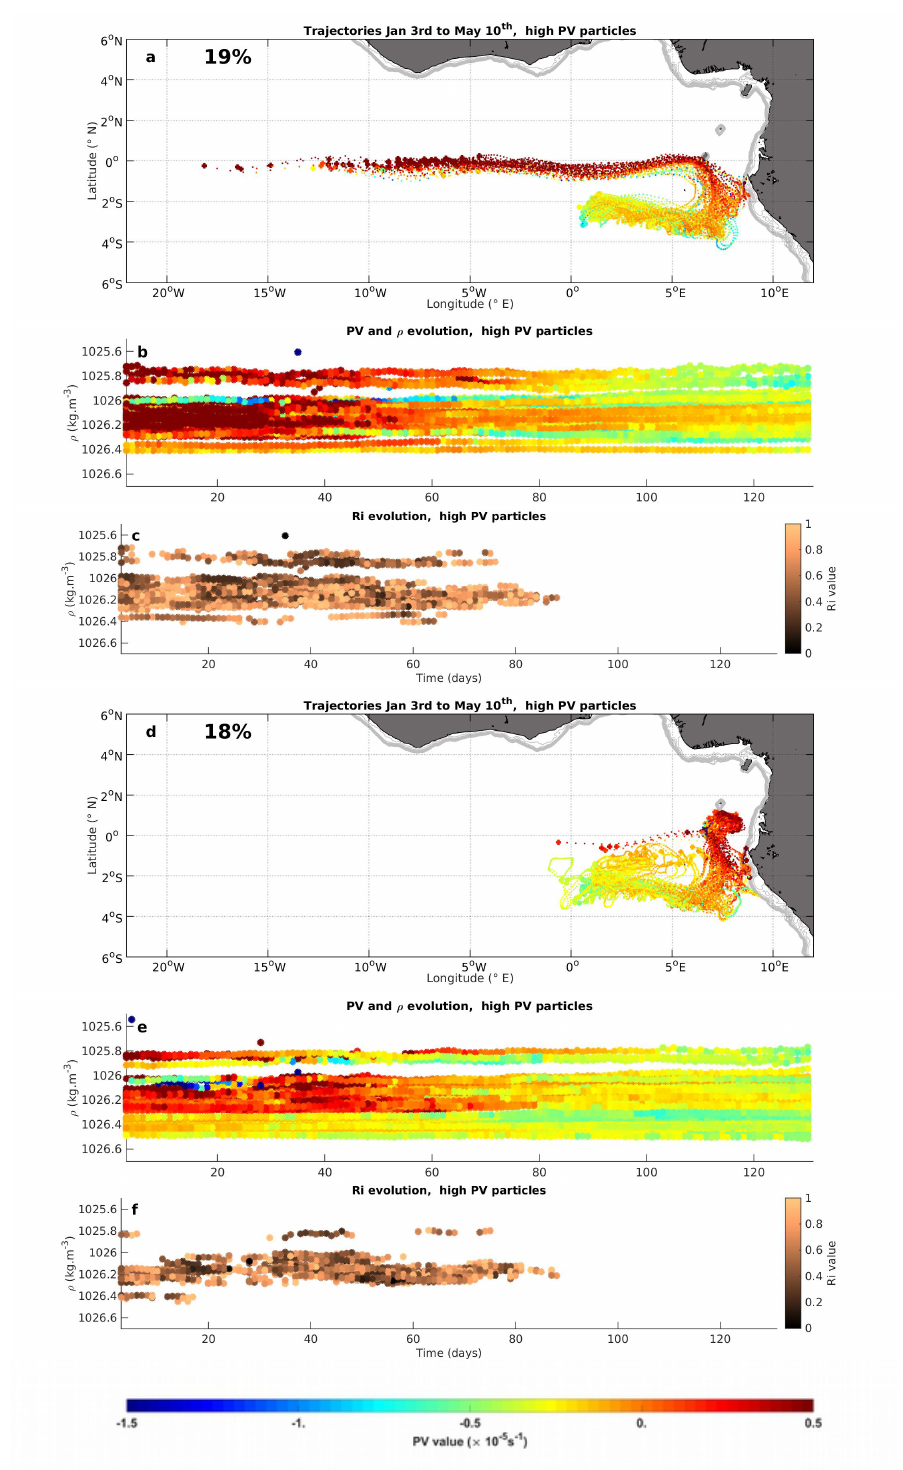
Figure 16. Same as Figure 15 but for high PV particles. The initial position is identified by the symbols + and the final positions by ∗ on trajectories; ( a – c ): particles with high PV values initially located along the Equator; ( d – f ): particles with high PV values initially located north-east of the final position, between Sao Tome and Principe islands. For ( a , b , d , e ), the color corresponds to the PV value during the evolution and the colorscale is the same as in Figure